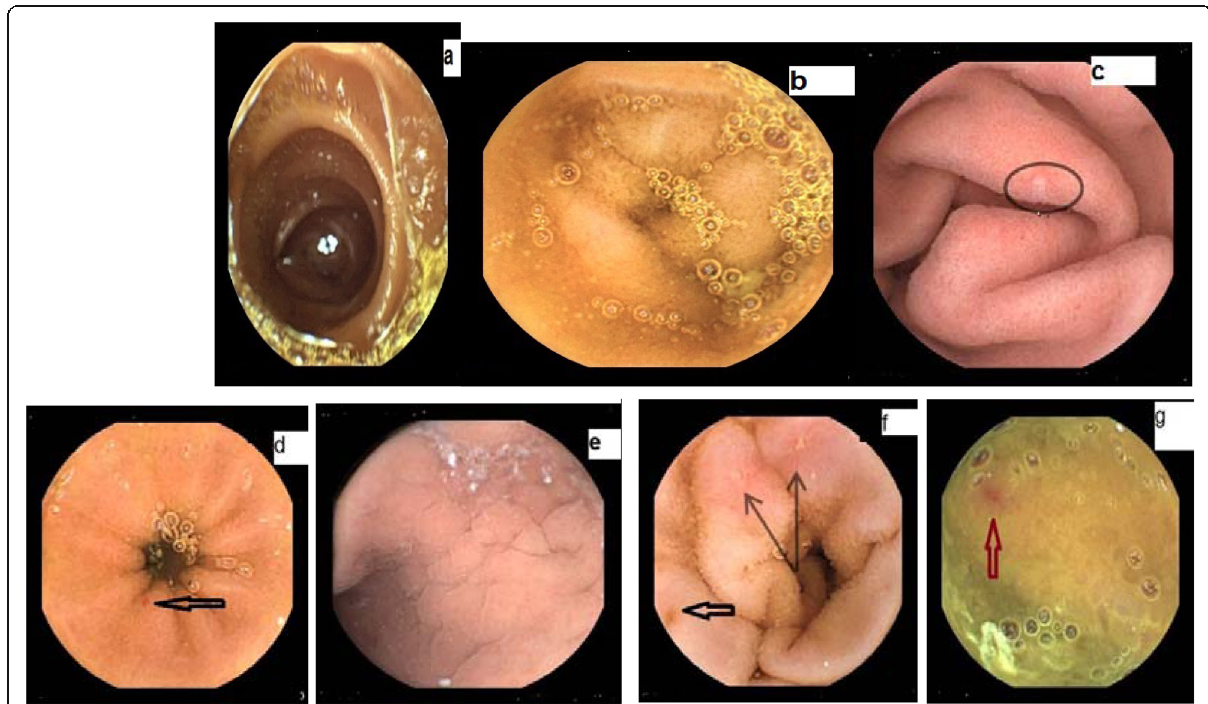
Fig. 1 Mucosal changes in portal hyertensive entropathy. a Normal intestinal mucosa. b mucosal edema with absence of the lumen. c Superficial erosion. d Red spot(arrow). e Mosaic appearance of edematous mucosa. f Superficial erosion (thin arrow) angioectasia (thick arrow). g Angiodysplasia (arrow)